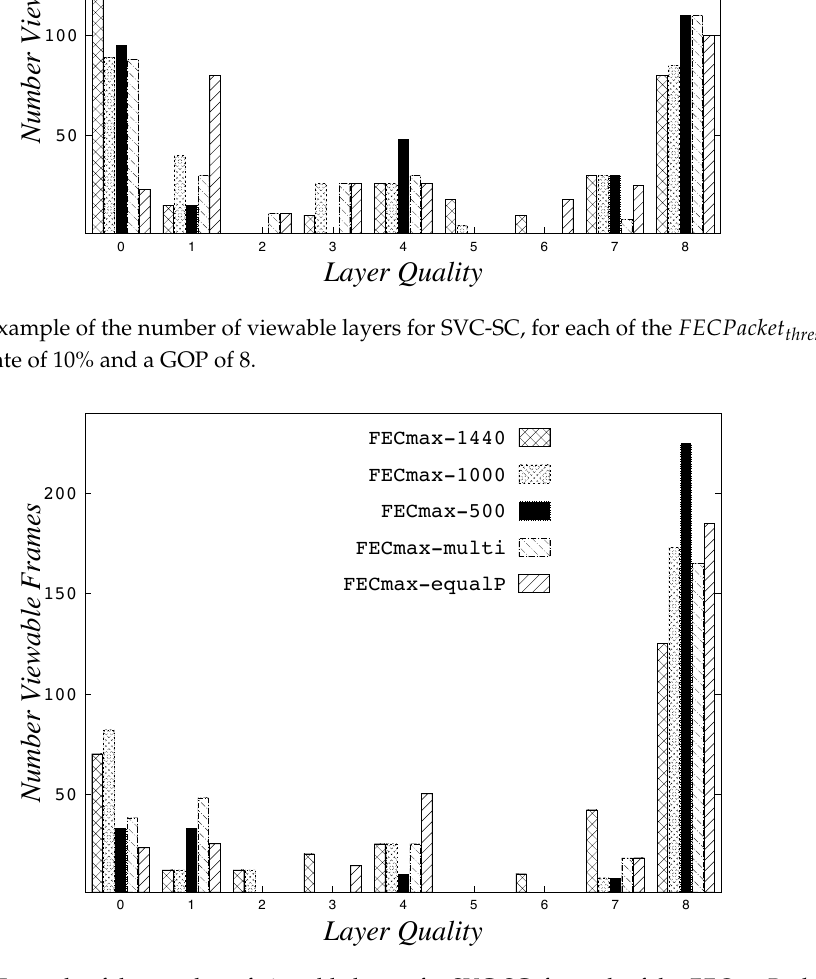
Figure A10. Example of the number of viewable layers for SVC-SC, for each of the FEC max Packet thres , at a packet loss rate of 10% and a GOP of